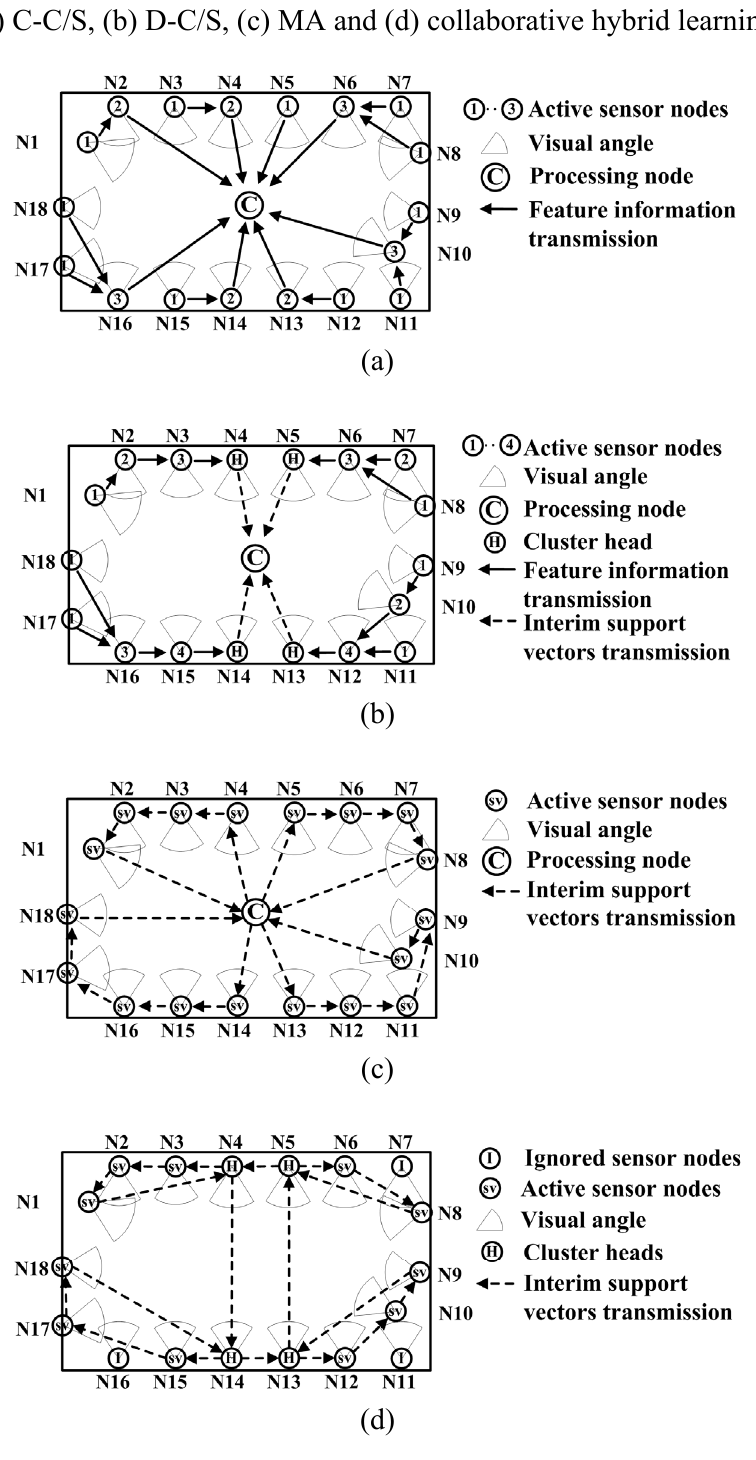
Figure 12. The deployment scenario of WMSN with different learning